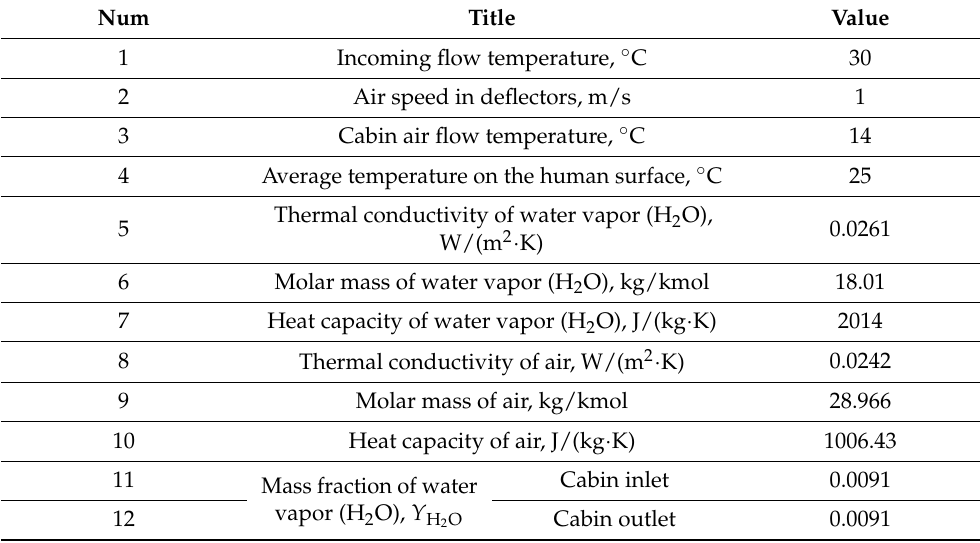
Table 2. Boundary conditions and environment